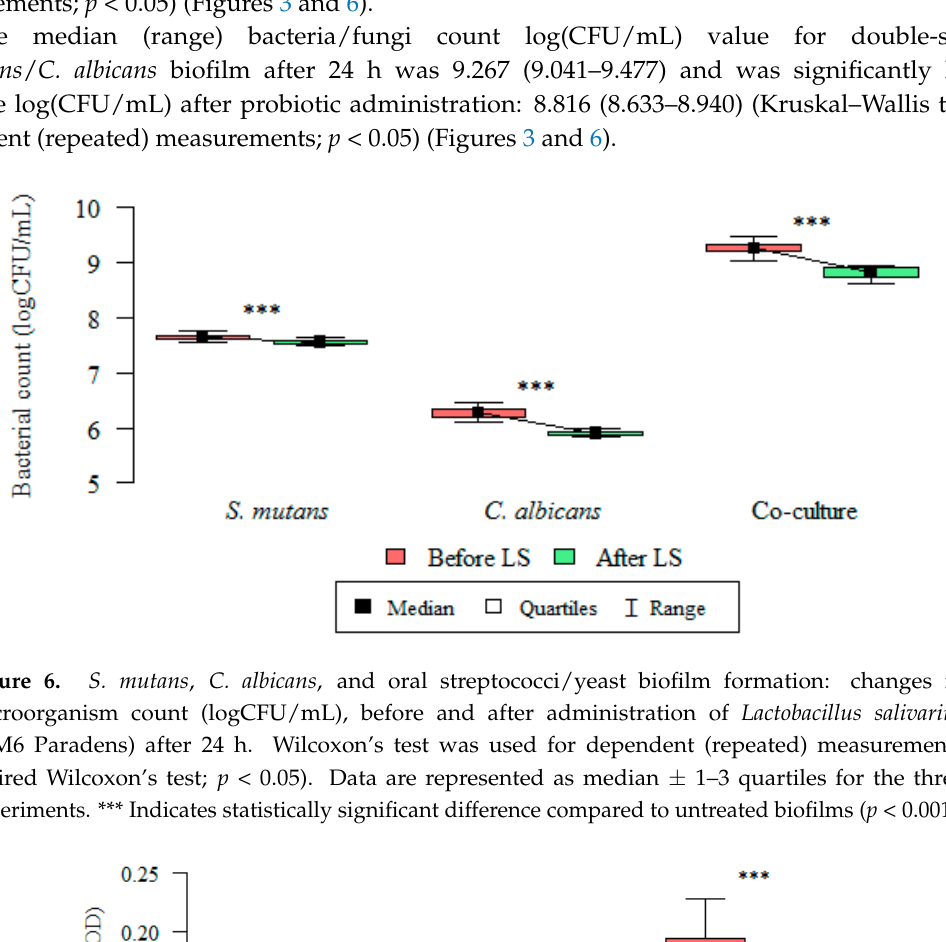
Figure 8. SEM images of the mono-species biofilm generated by C. albicans , S. mutans and the double- species oral streptococci/yeasts biofilm—untreated and treated with the Lactobacillus salivarius (HM6 Paradens)—after 24 h of biofilm formation. ( A ) The 24 h C. albicans biofilm formed on a flat agar surface (Agar Scientific, Stansted, UK); ( B ) The 24 h C. albicans biofilm formed on a flat agar surface